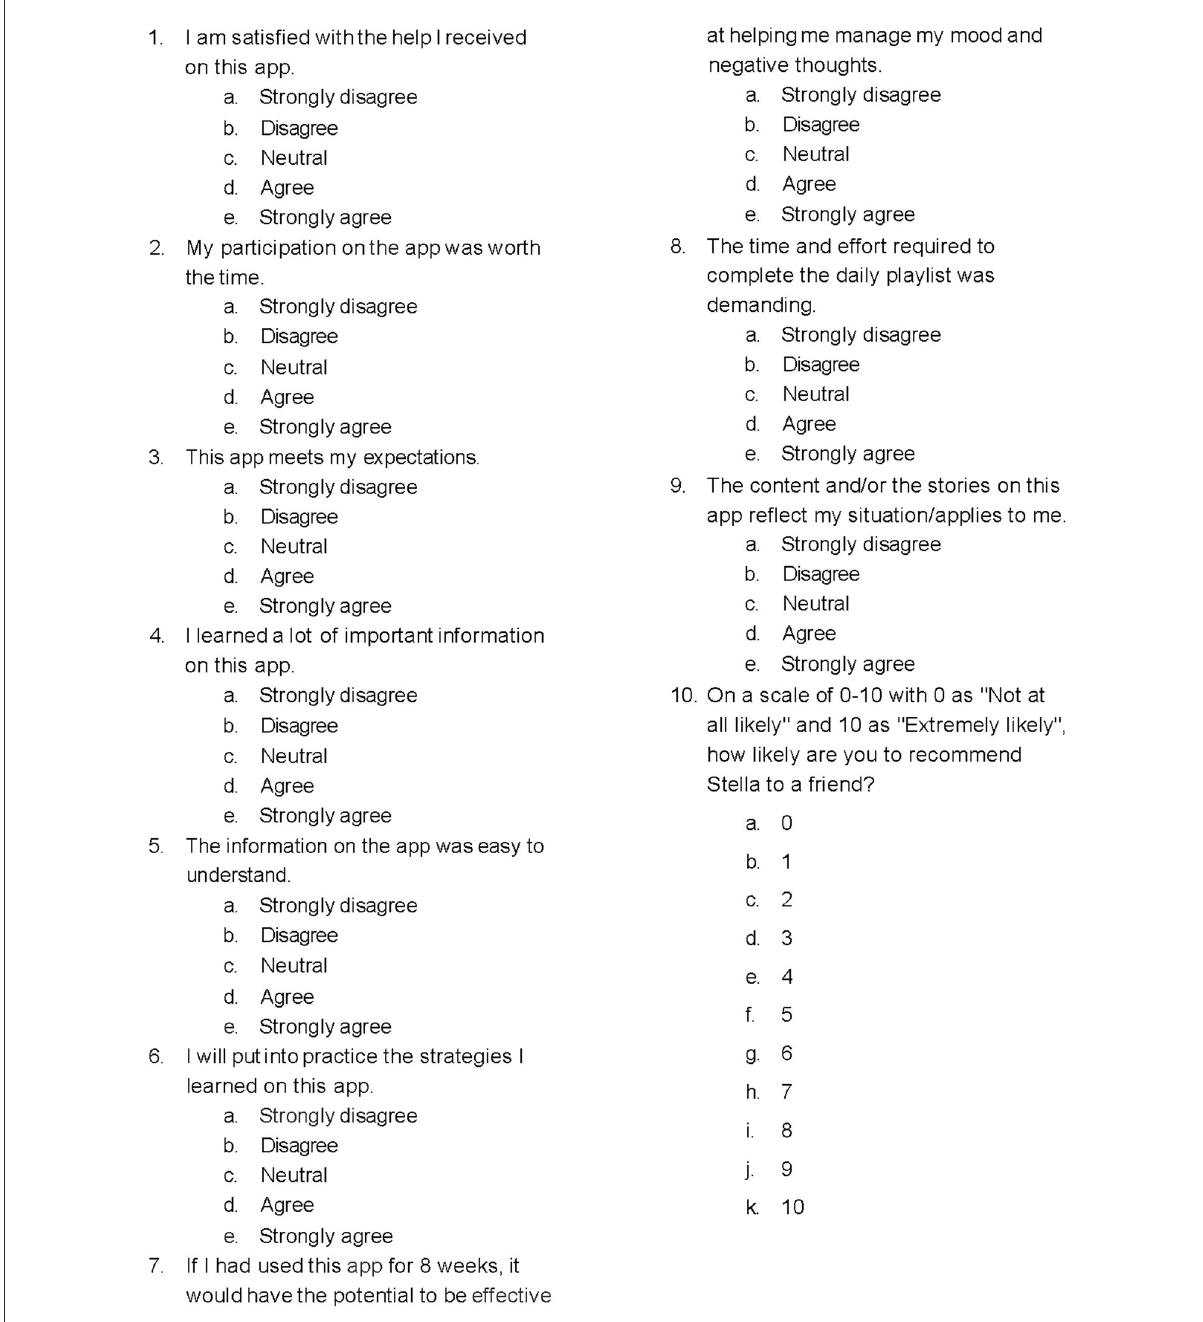
FIGURE1 Acceptability